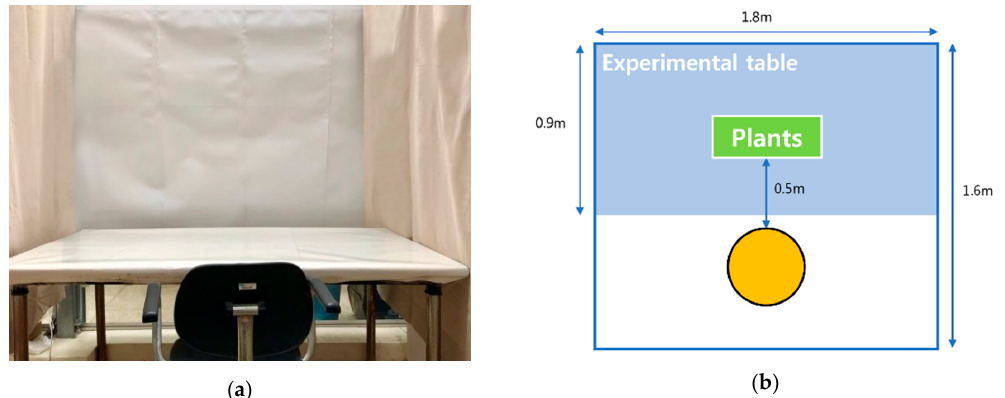
Figure 1. Experimental conditions: ( a ) Photograph of the experimental room; ( b ) Arrangement during the experiment.